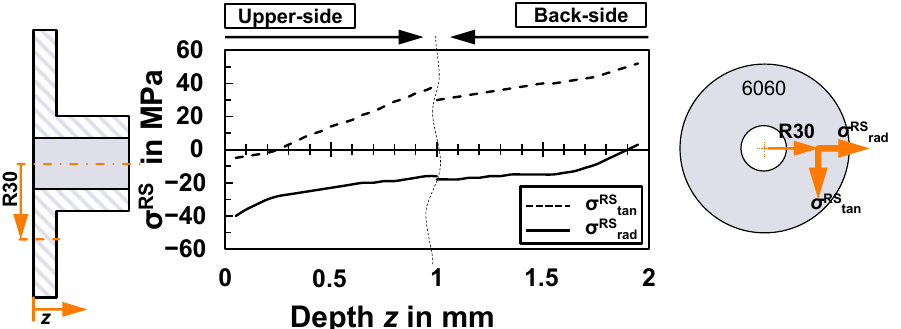
Figure 9. Continuous residual stress depth distribution. Flange formed by the friction spinning of aluminium tubes (6060). Process parameters: feed rate f = 3 mm/s, rotation speed n = 900 rpm, quenching v t performed with water after the process at T = 150 °C, wall thickness s = 2 and tool angle α = 45.